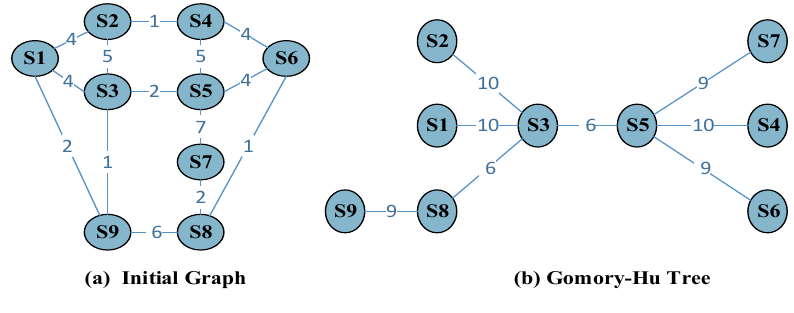
Fig. 5. Gomory-Hu Transformation Example.